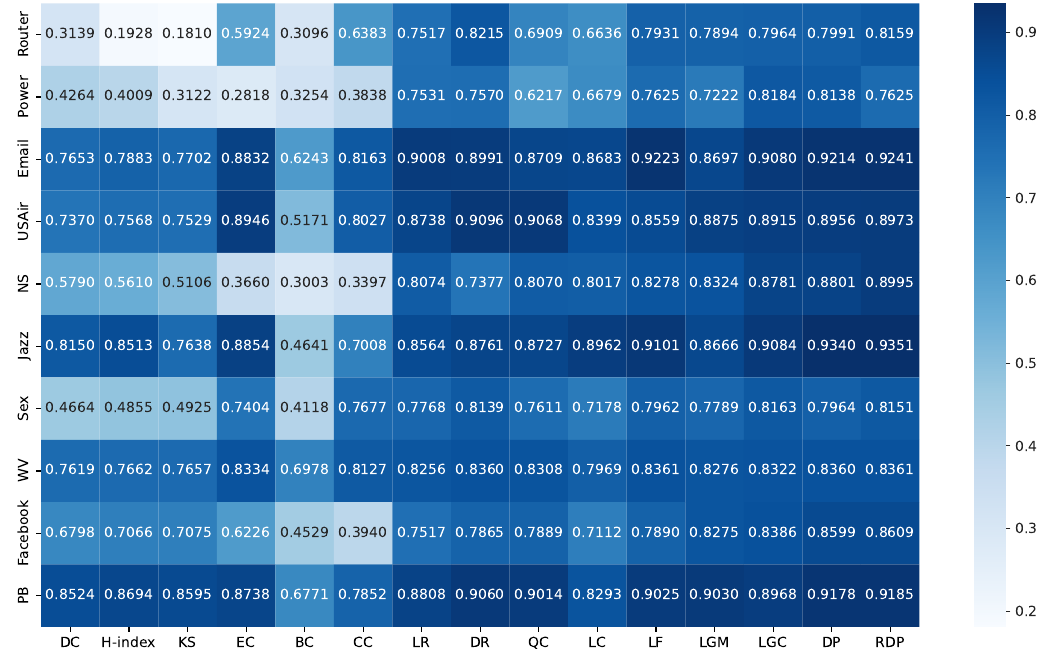
Figure 2. The accuracies of DP/RDP and 13 benchmark algorithms for β = β c